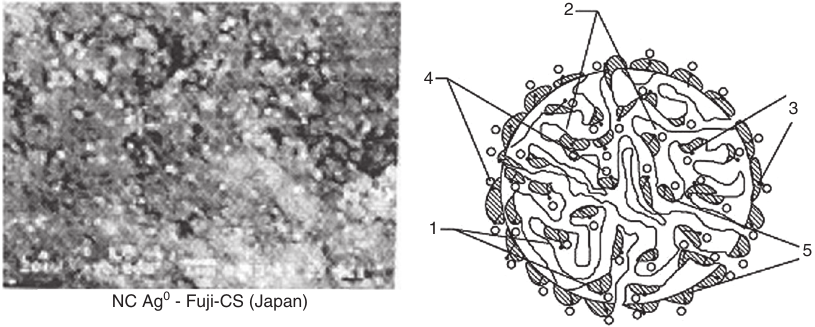
Figure 1 (A, B) Mass transfer inside bifunctional NC matrix: (A) experimental NC microphotography, magnification: 10,000, (B) illustration of NC r -bead ( ro -fiber); 2-micropores, 3-fixed groups R , 4-counterions, 5-Me 0 -NP agglomerates (shaded, B)